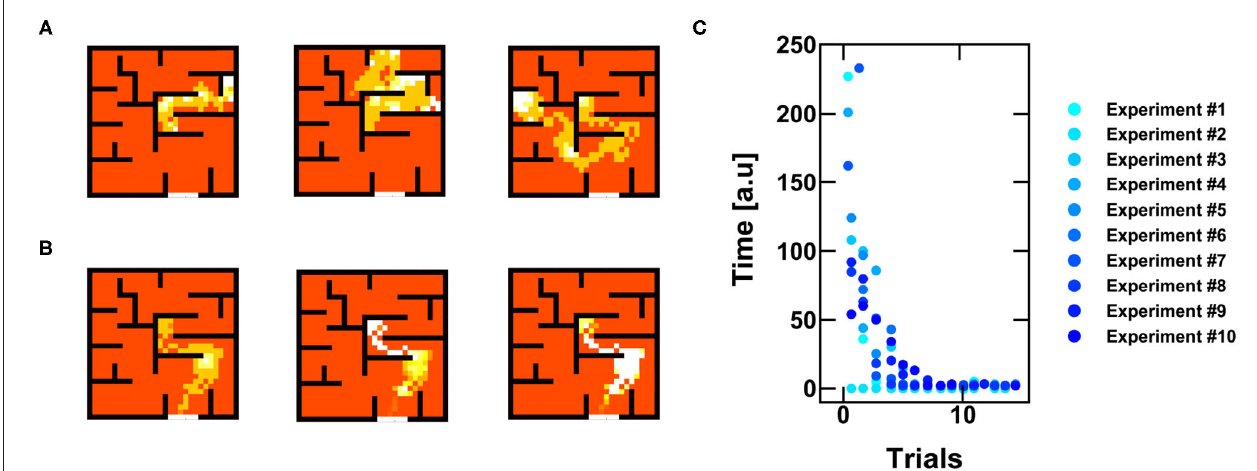
FIGURE 8 | (A) Example of three random walks for successive trials of exploration of the agent. (B) Example of three successive trials after finding the escape path: the agent progressively improves its policy for finding the reward, eventually not committing errors anymore. (C) Time to get to the escape path as a function of the number of trials for 10 different experiments of 15 trials